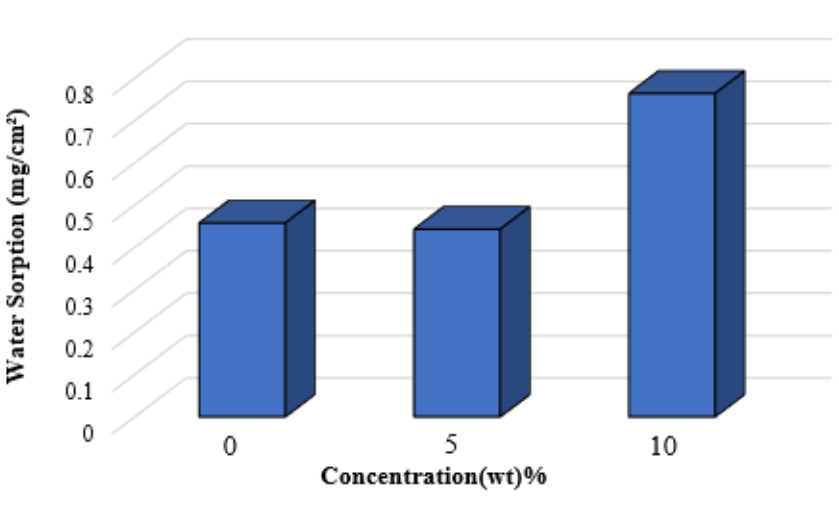
Figure 6: Mean values of water sorption as a function of fiber